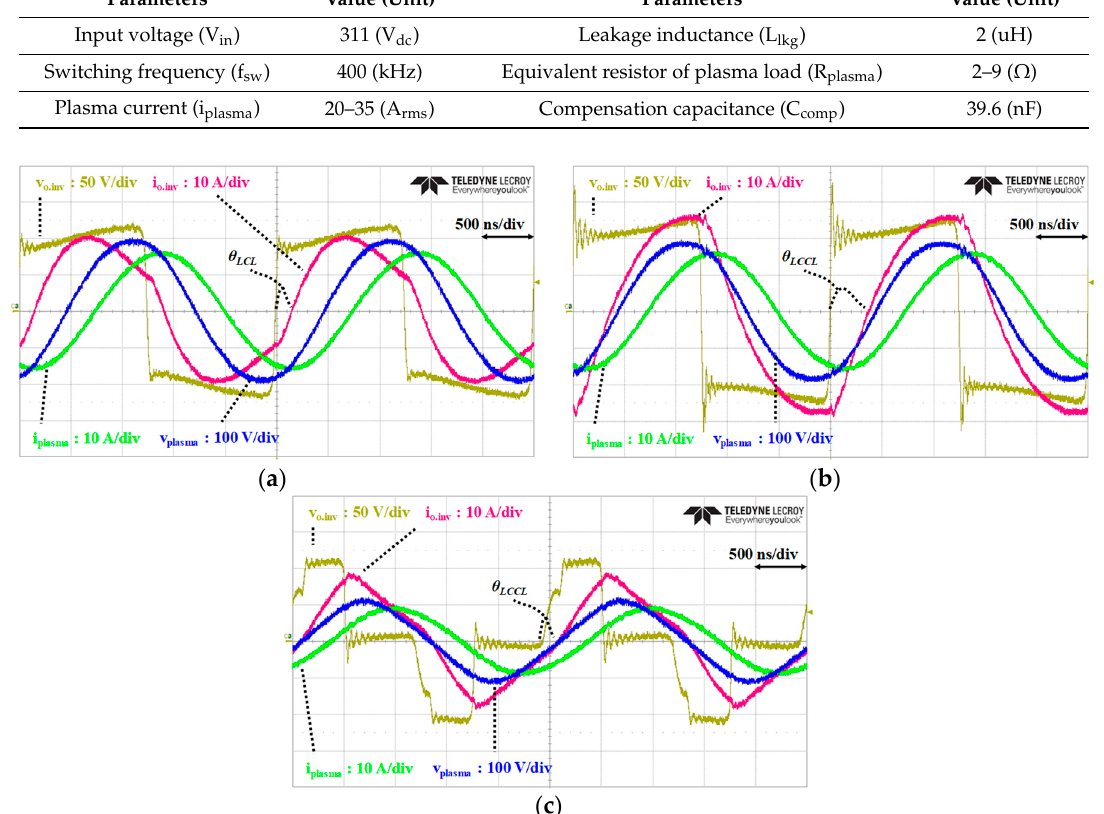
Figure 10. Feasibility test results of experimental waveform of each resonant network: ( a ) experimental waveform of the LCL network under the 9 Ω , 11.6 A conditions; ( b ) experimental waveform of the LCCL network under the 9 Ω , 11.6 A conditions; and ( c ) experimental waveform of the LCCL network under the 9 Ω , 6.6 A conditions. Table 1. Parameters of the inverter and both resonant networks for simulation and experiment.